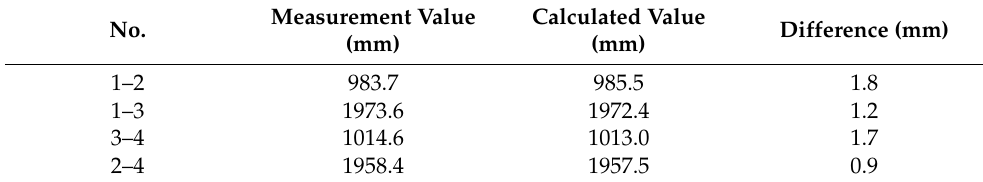
Figure 15. Checkpoints used for distance verification. Table 6. Distance between checkpoints and the error.